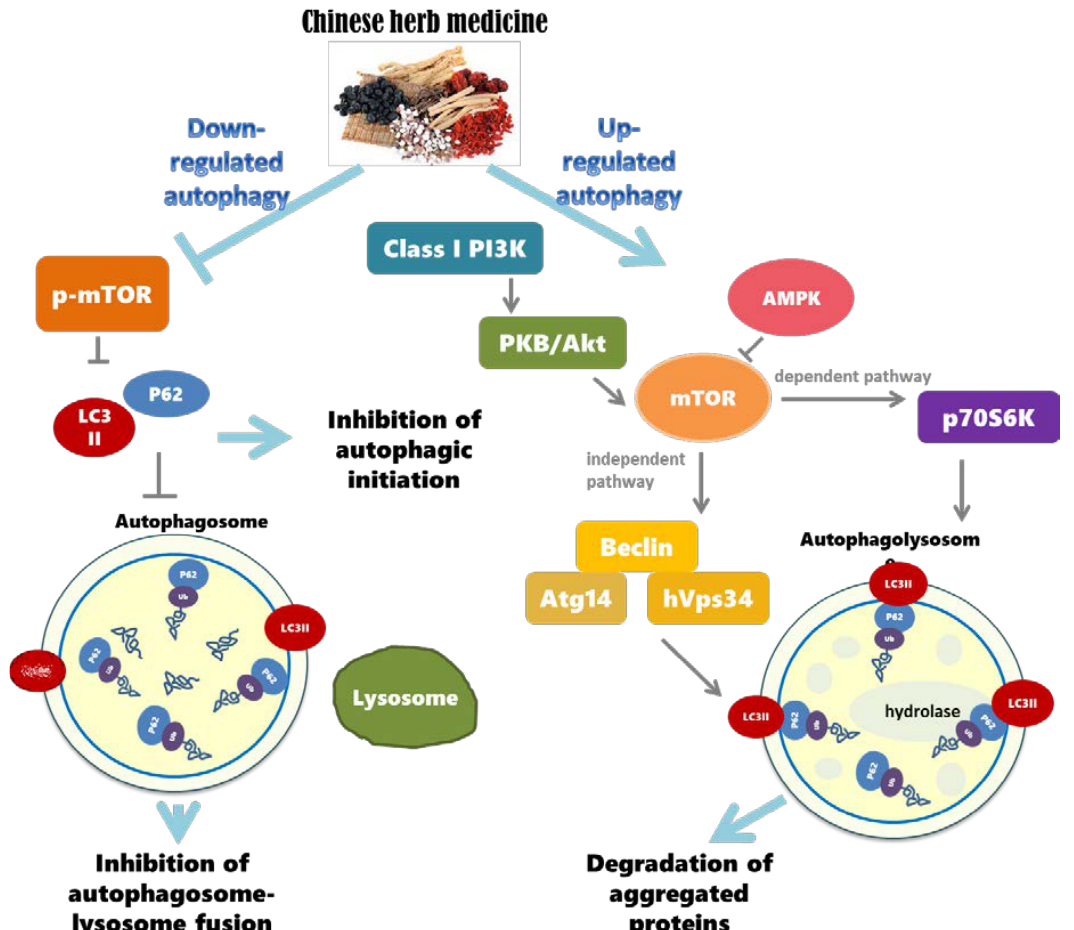
Figure 2. Autophagy regulation by Chinese herb medicine.